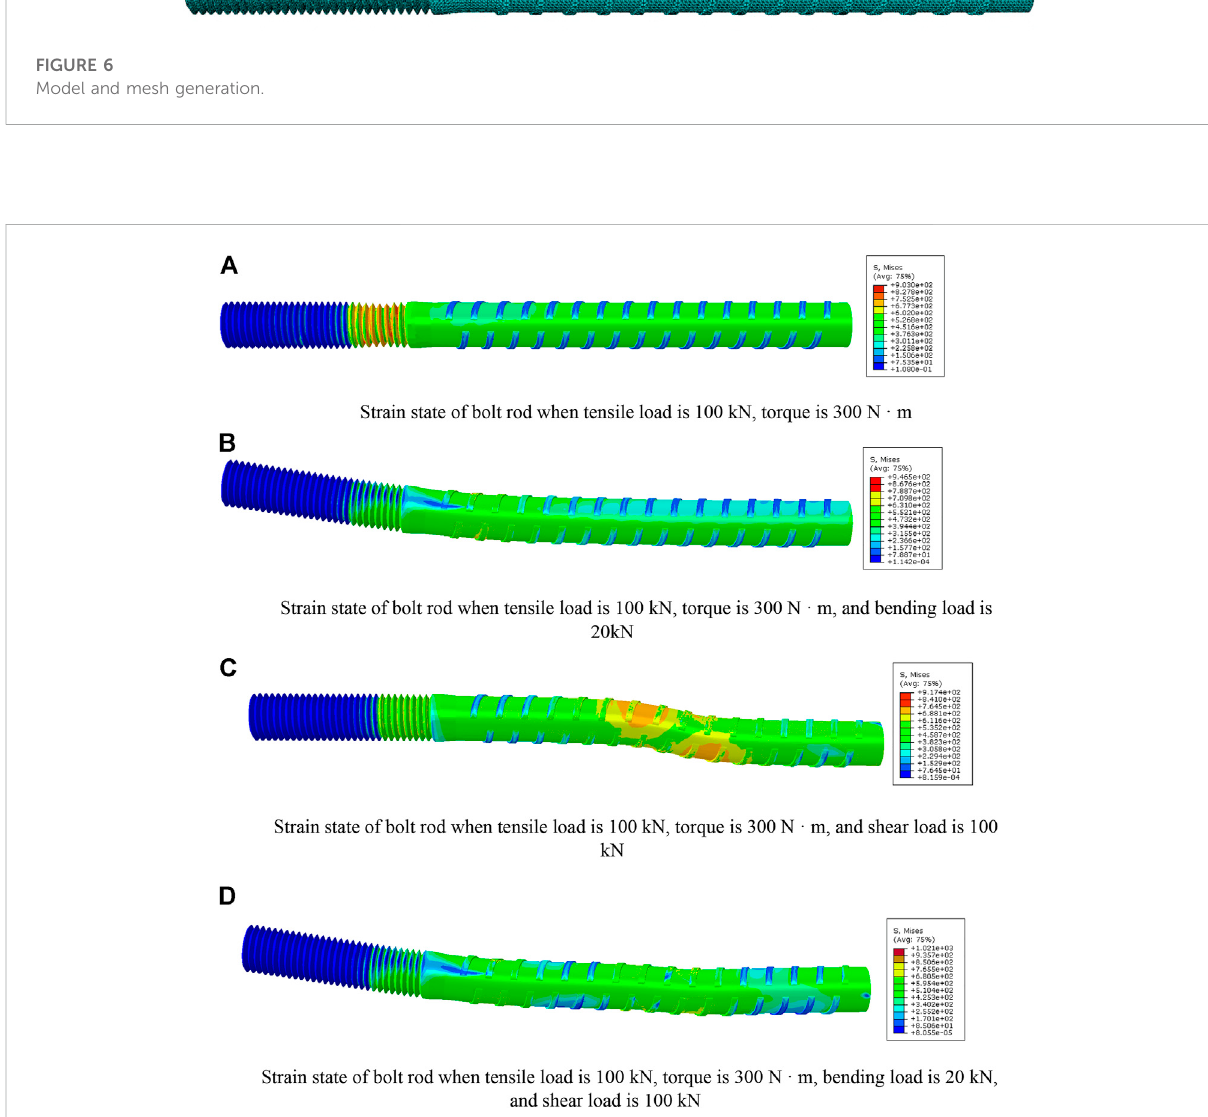
FIGURE 7 Stress-strainstateoftheboltundercompositestressstate. (A) Strainstateofboltrodwhenatensileloadis100 kN,torqueis300 N m. (B) Strain stateofboltrodwhenatensileloadis100 kN,torqueis300 N m,andbendingloadis20 kN. (C) Strainstateofboltrodwhenatensileloadis100 kN, torque is 300 N m, and shear load is 100 kN. (D) Strain state of bolt rod when tensile load is 100 kN, torque is 300 N m, bending load is 20 kN, and shear load is 100